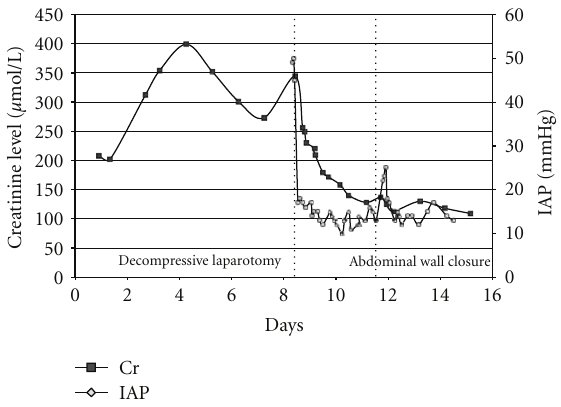
Figure 2: IAP and creatinine profiles (Case